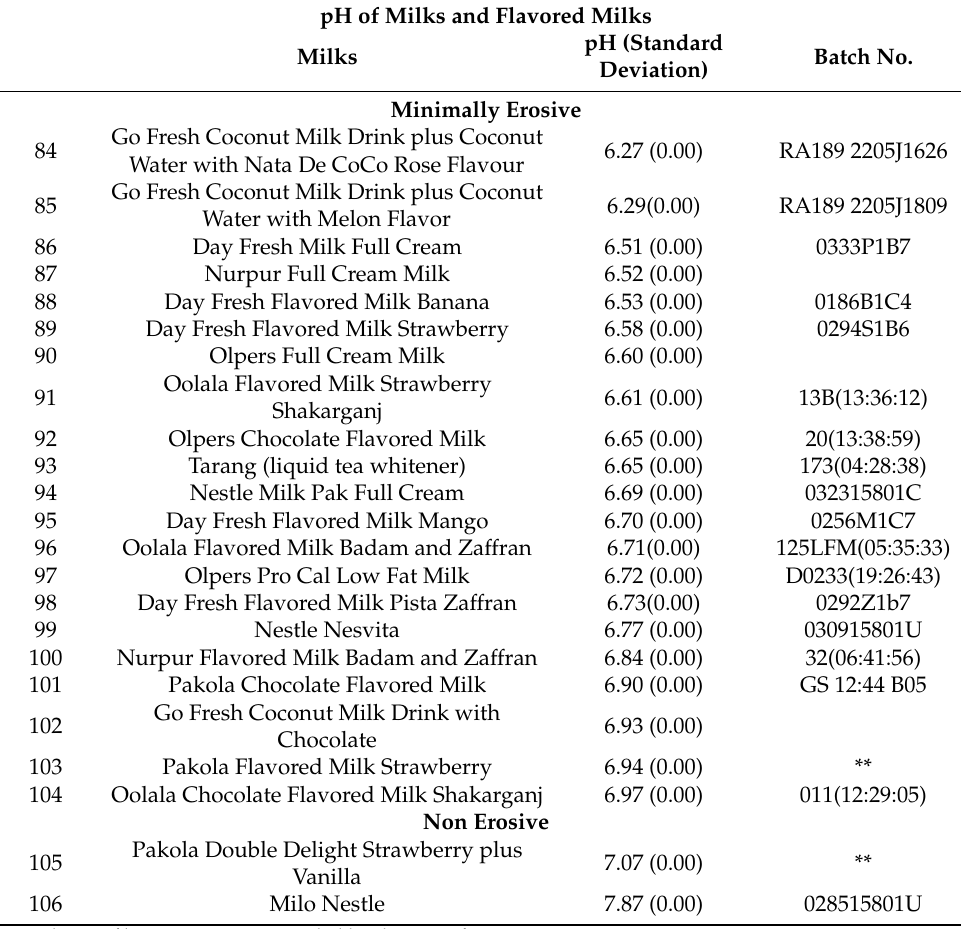
Table 6. pH (mean and standard deviation) of milks and flavored